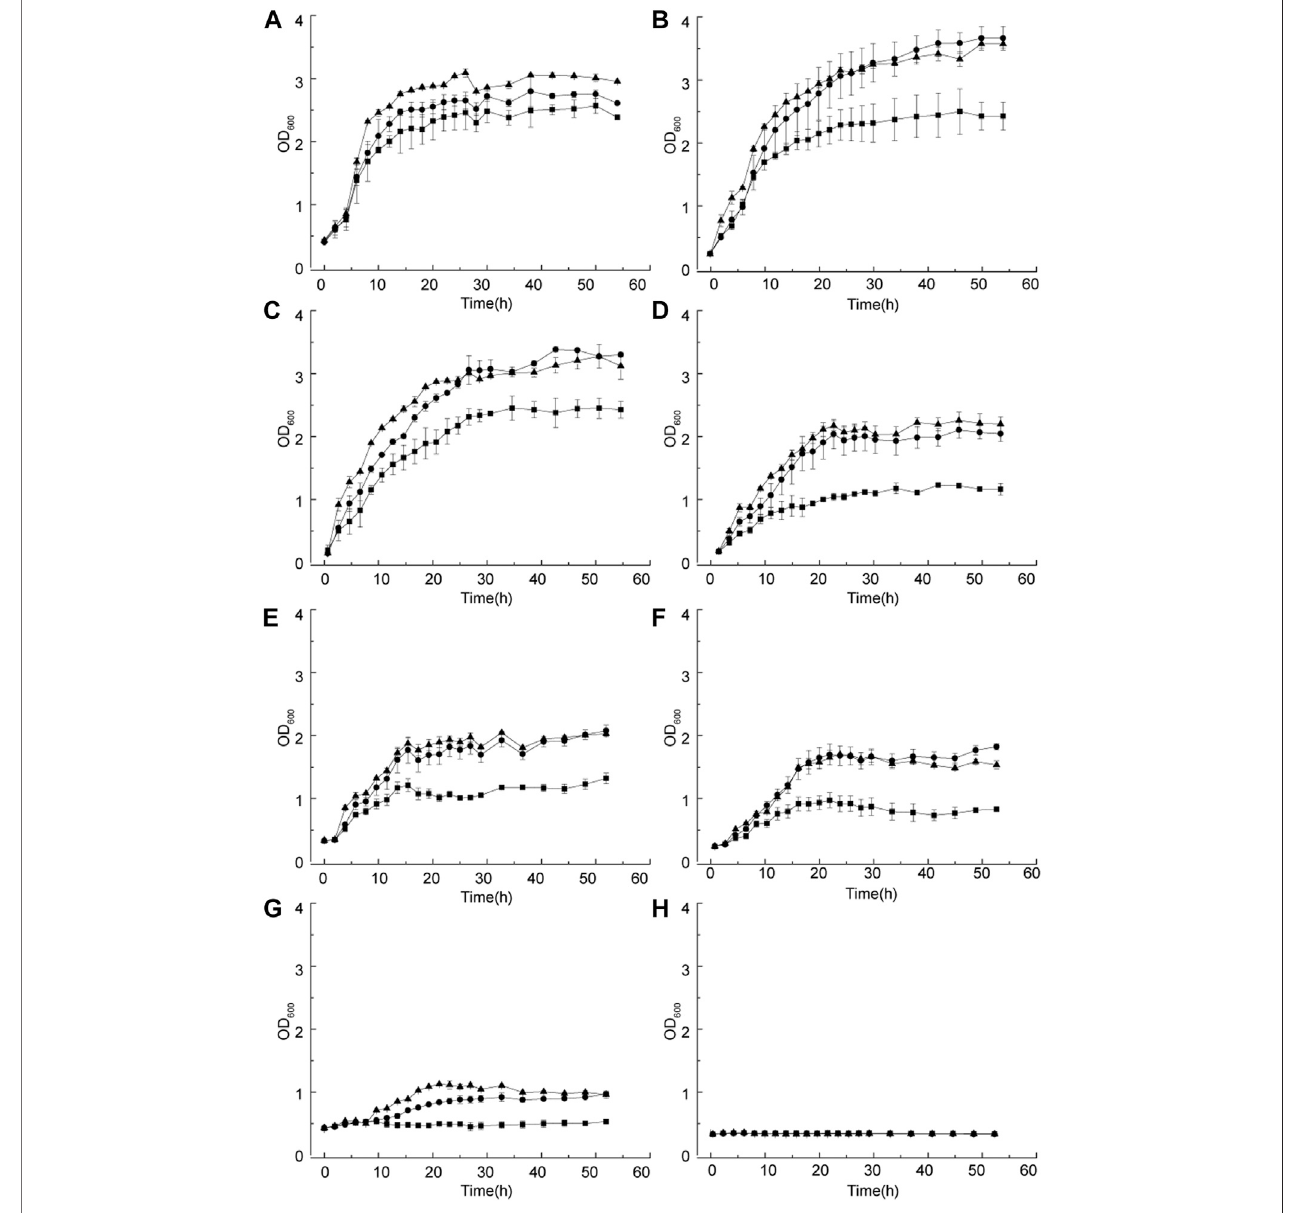
FIGURE 5 | Growth curve of G. oxydans with different D-sorbitol concentrations. (A) 50 g/L, (B) 100 g/L, (C) 150 g/L, (D) 200 g/L, (E) 250 g/L, (F) 300 g/L, (G) 350 g/L, and (H) 400 g/L. Square: G. oxydans WSH-004; circle: G. oxydans MMC2; and up-triangle: G. oxydans MMC4.